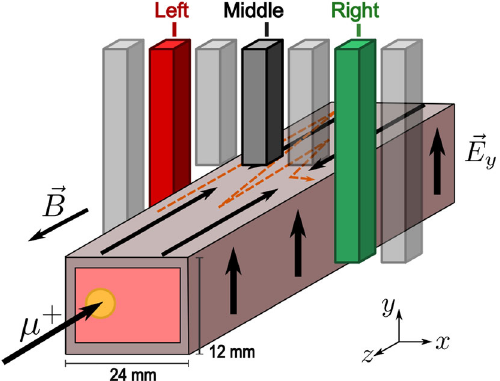
Fig. 9 Sketch of the setup to measure the E × B drift. The muon beam wasinjectedoff-axis toallowthemuons todrift alonger distancebefore hitting the lateral wall. The electric field has a z -component for longitu- dinal compression and a y -component to drift the muons in x -direction. Seven plastic scintillators are positioned above the target at z = 0, but at different x -coordinates, to monitor the muon swarm movement in the x -direction. The scintillators had a cross section of 2 × 2 mm 2 and length (in the y -direction) of 32 . 5 mm for the three central scintillators and 48 . 5 mm for the four scintillators on the left and right sides of the target